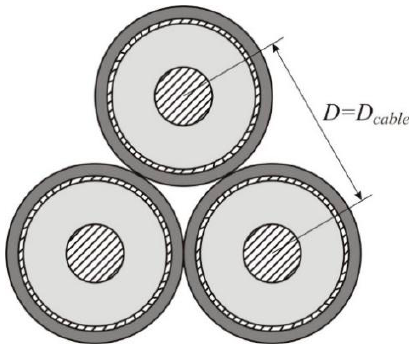
Figure A4. Single-core cable in the trefoil formation.